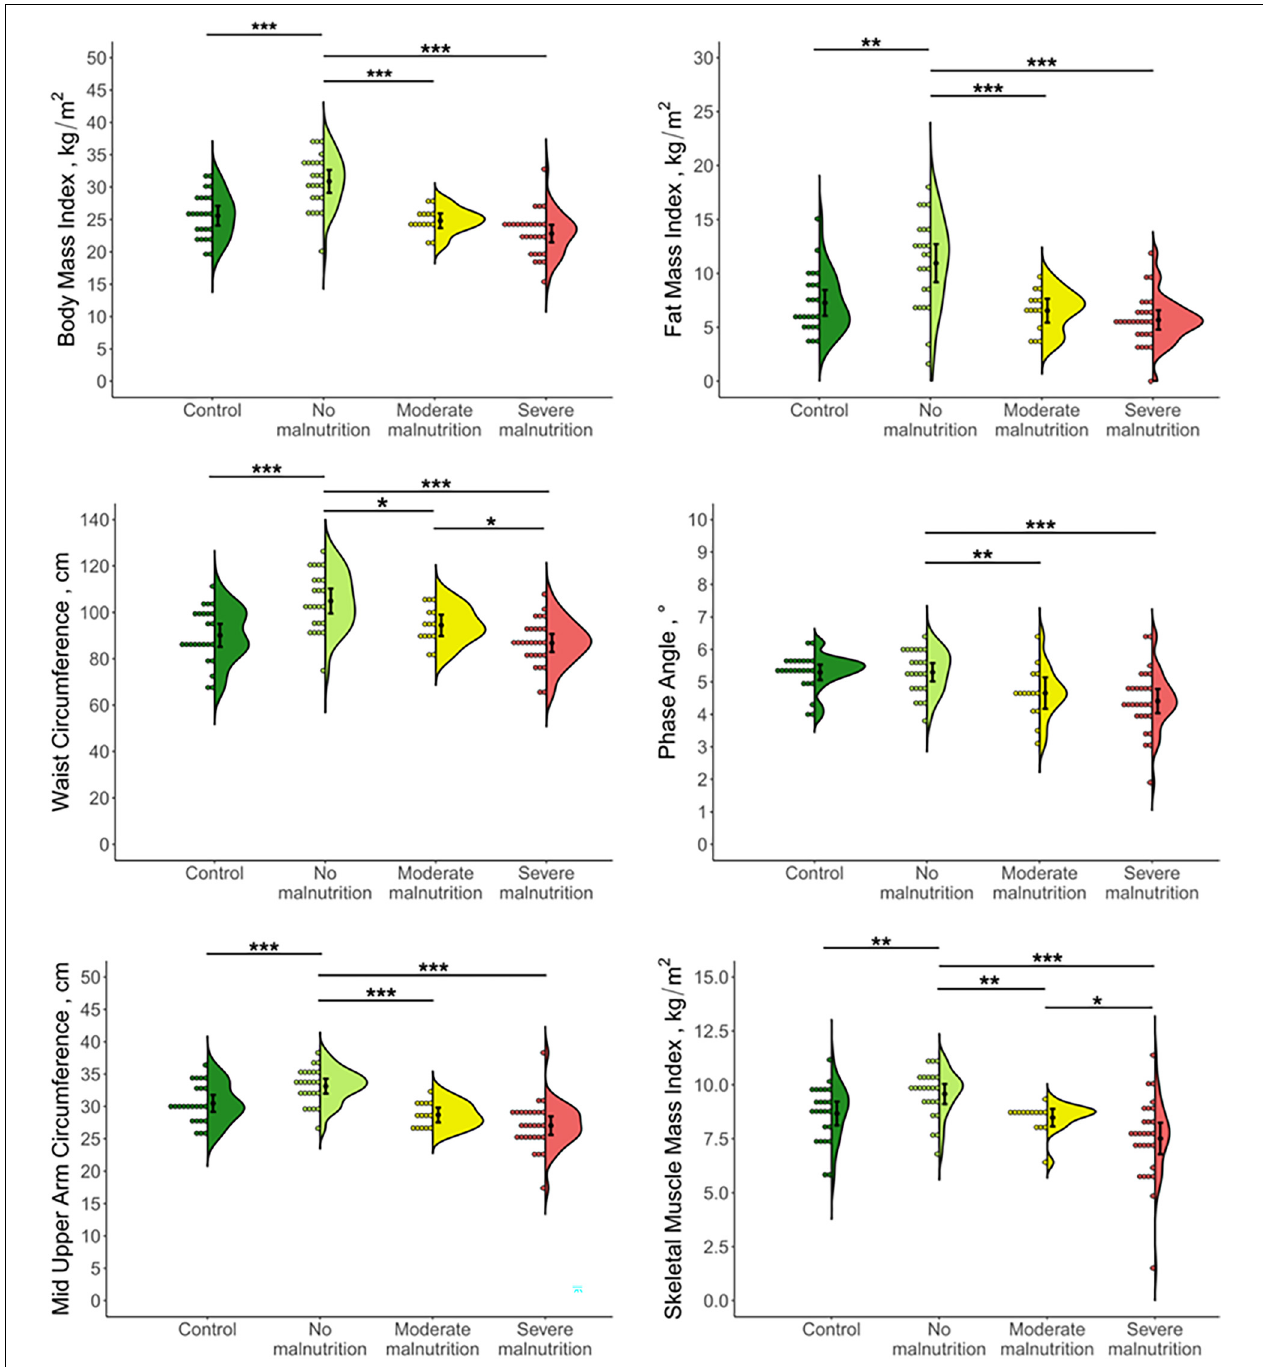
FIGURE 1 | Jellyfish plots of anthropometric and body composition parameters in patients with chronic pancreatitis stratified by nutritional status and healthy controls. Distribution of data is presented as a combination of histogram (left), mean ± SD (center), and kernel density estimated probability density function (right). Differences between groups were tested by two-tailed t -test. * p < 0.05, ** p < 0.01, *** p <